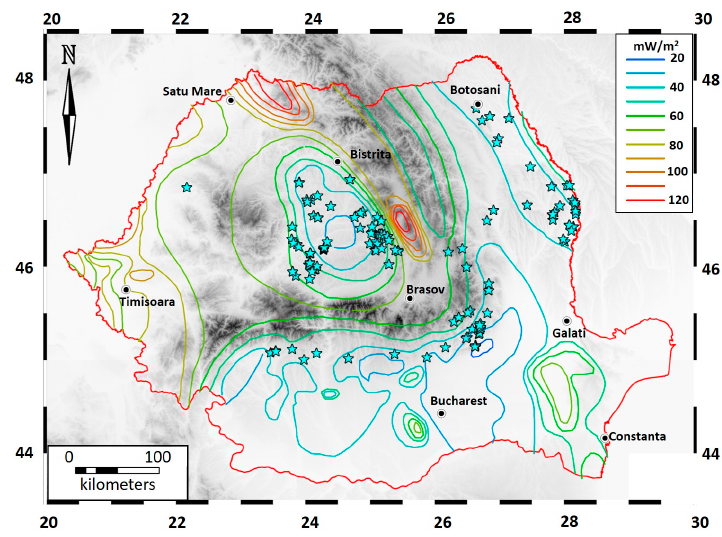
Figure 9. Distribution of active and inactive seeps of the HYSED-RO database in relation to the heat flow (modified after [47,50–52]).